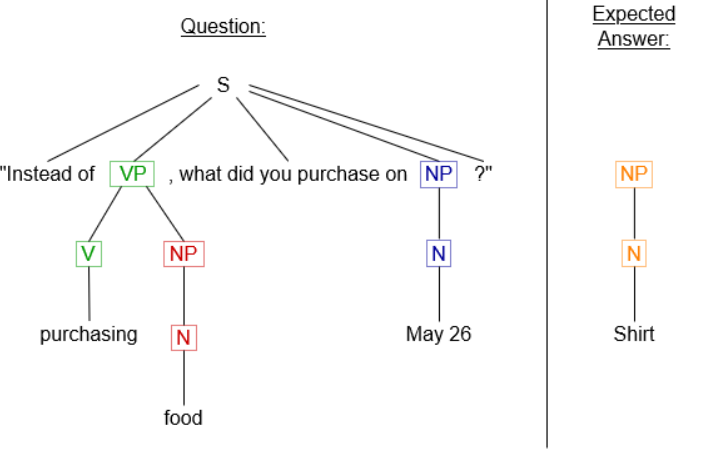
Figure 6. A full sentence template.